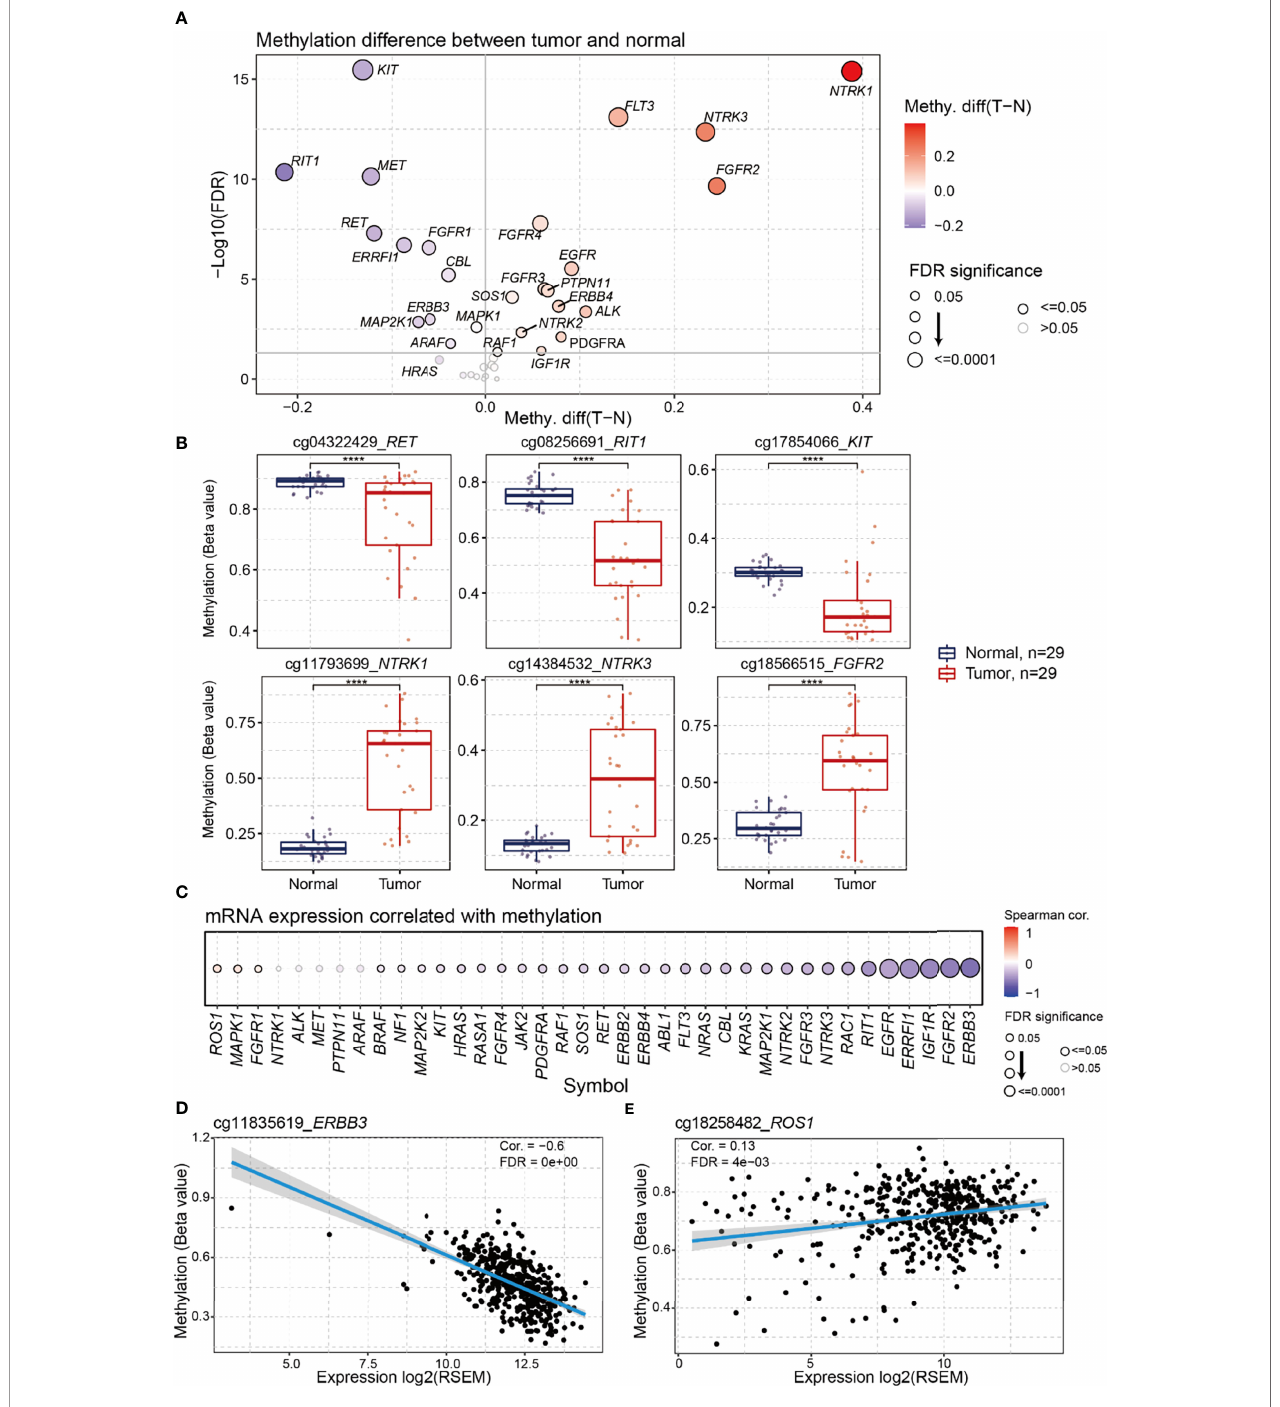
FIGURE 3 | Differential methylation of RTK/RAS pathway and its correlation with mRNA expression. The methylation sites used in this analysis were showing in Table S2 . (A) Methylation difference between tumors and normal samples. Blue and red bubbles represent a decrease and increase in methylation in tumors compared with that in normal samples, respectively. Bubble size is positively correlated with the FDR signi fi cance. (B) Boxplot showing the difference in RET , RIT1 , KIT , NTRK1 , NTRK3 , and FGFR2 methylation between tumors and normal samples. ****FDR < 0.0001. (C) Bubble plot summarizing the Spearman correlation between the methylation and mRNA expression of RTK/RAS pathway genes. Blue and red bubbles represent negative and positive correlations, respectively. Bubble size is positively correlated with the FDR signi fi cance. The black outline borders indicate FDR ≤ 0.05. Scatter plot with a fi tted line showing the detailed relationship between the mRNA expression and methylation of (D) ERBB3 and (E) ROS1